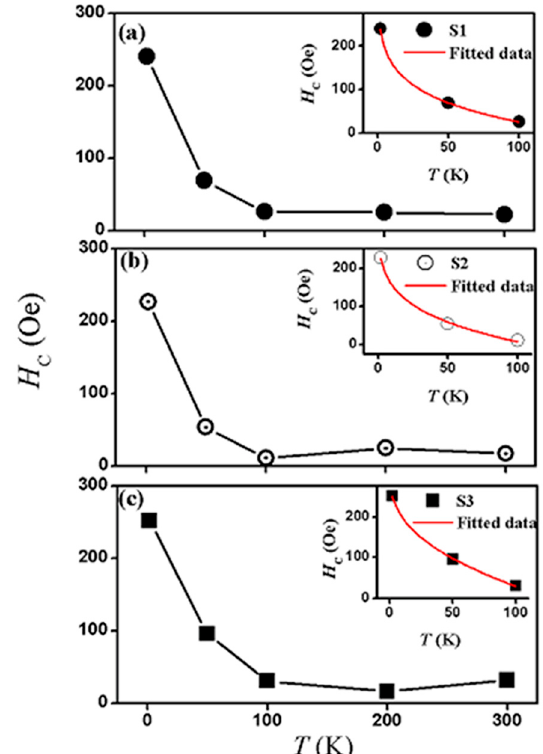
Figure 5. Temperature-dependent coercivity ( H C ) under zero field-cooling conditions for samples ( a ) S1; ( b ) S2; and ( c ) S3. The insets show the fitted data corresponding to each sample.